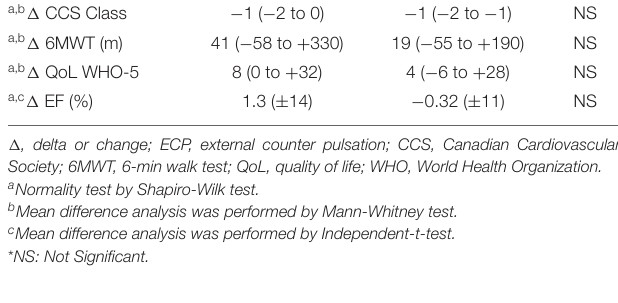
TABLE 5 | Differences in CCS class, 6MWT and QoL WHO-5 in ECP and sham group, before and after intervention. Variable ECP ( n =